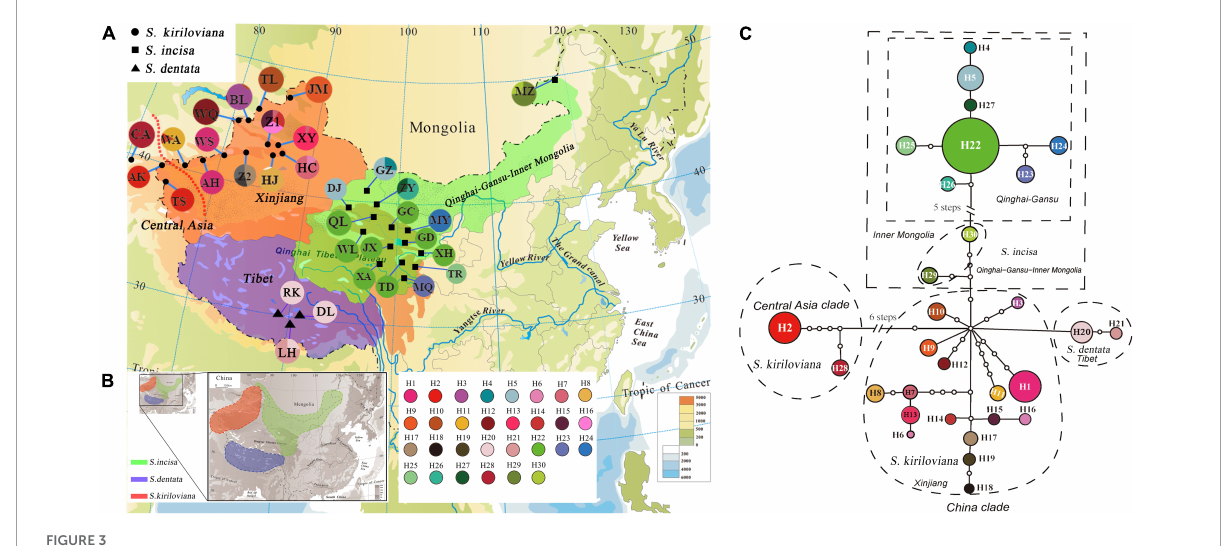
FIGURE3 (A) Geographic distribution of the 30 chloroplast (cp) DNA ( trn L- trn F and psb A- trn H) haplotypes (H1–H30) detected in the Scrophularia incisa complex (see Supplementary Table 1 for population codes). Red dashed lines denote divergences identified by TCS and phylogenetic analyses. (B) Geographic ranges of S. incisa , S. dentata and S. kiriloviana . (C) TCS-derived network of genealogical relationships of the 30 cpDNA haplotypes. The small open circles represent missing haplotypes. The size of circles corresponds to the haplotype frequency.